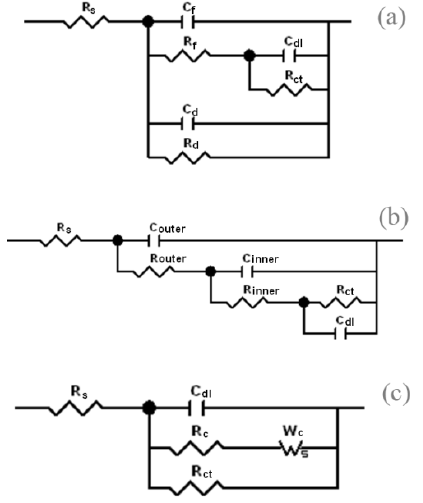
Figure 3. Equivalent circuits of the models used previously: ( a ) the equivalent circuit of original Deslouis’s model [3]; ( b ) the equivalent circuit of Chung’s model [32]; ( c ) the equivalent circuit of Barchiche and Deslouis’s model